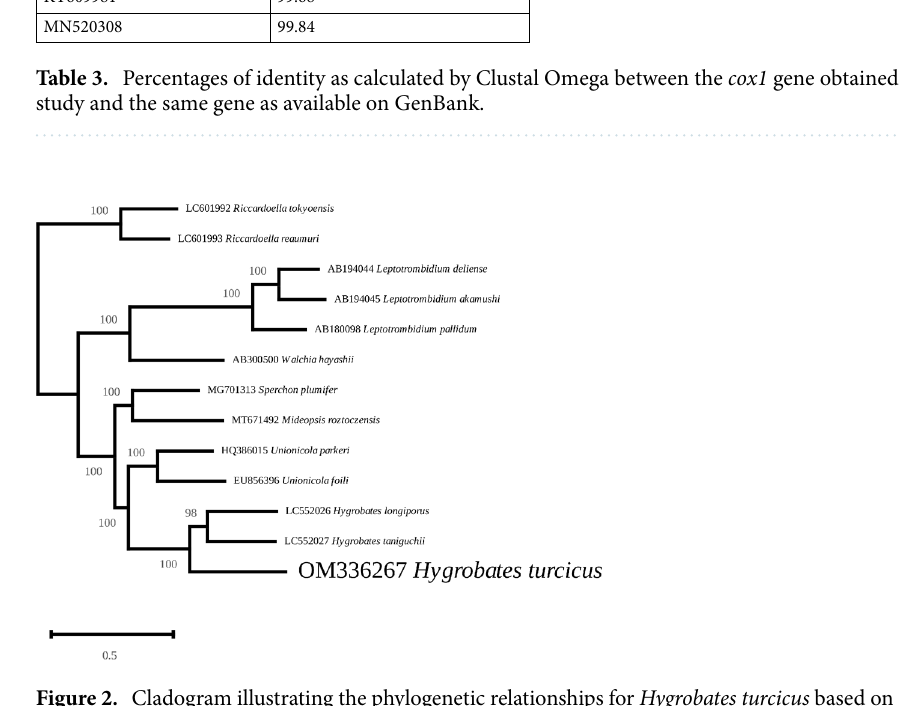
Figure 2. Cladogram illustrating the phylogenetic relationships for Hygrobates turcicus based on complete mitochondrial genome sequences. Mitochondrial genome rearrangement events are mapped on the branches of the best scoring maximum likelihood tree generated with RAxML-NG. Each node has 100% bootstrap support